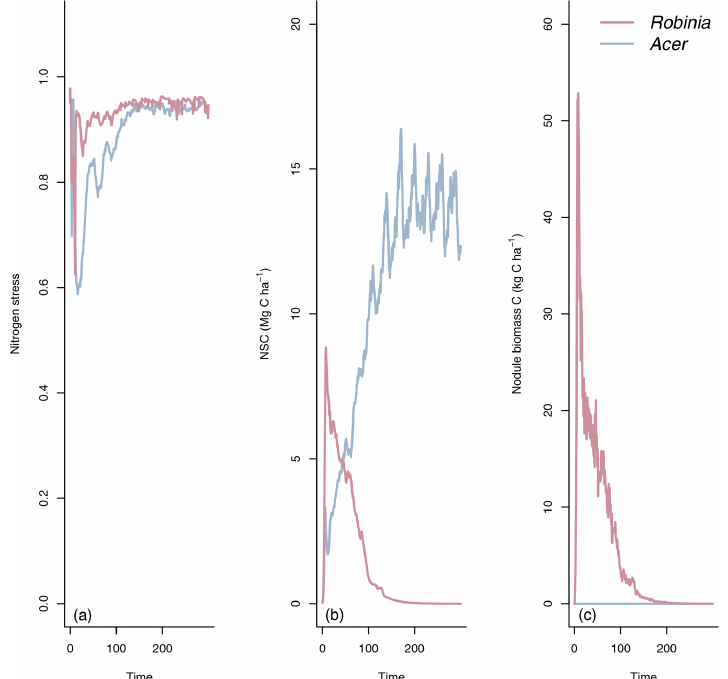
Figure D4. Controls of symbiotic BNF. (a) Nodule biomass C, (b) non-structural C, and (c) N stress.